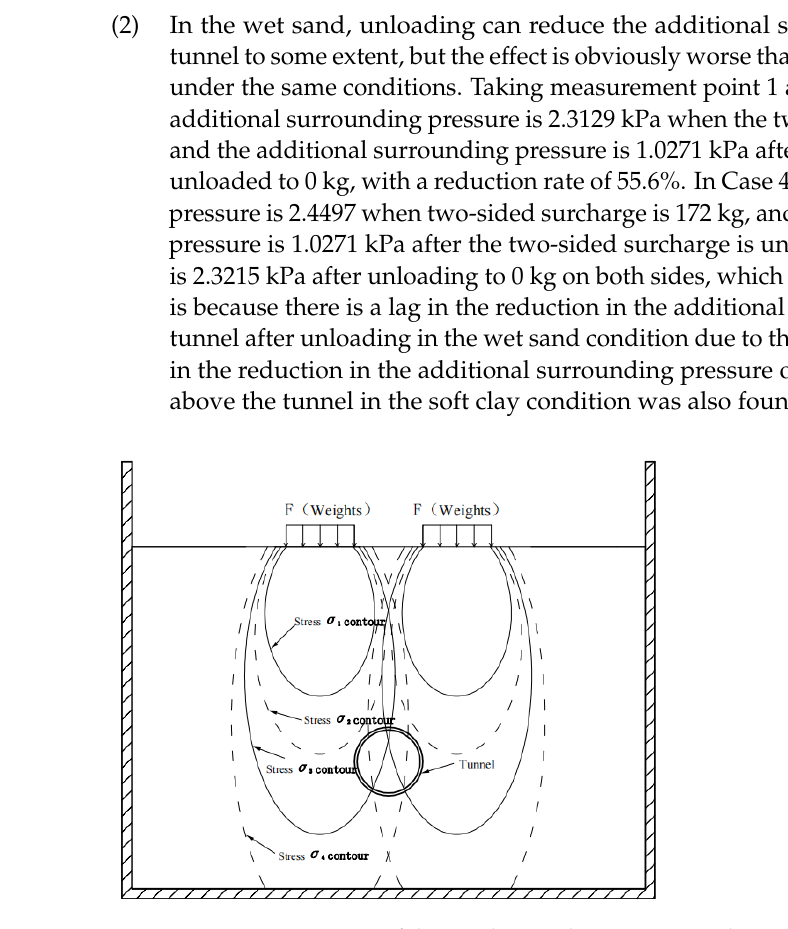
Figure 22. Stress σ contour of dry sand at surcharge on two sides.